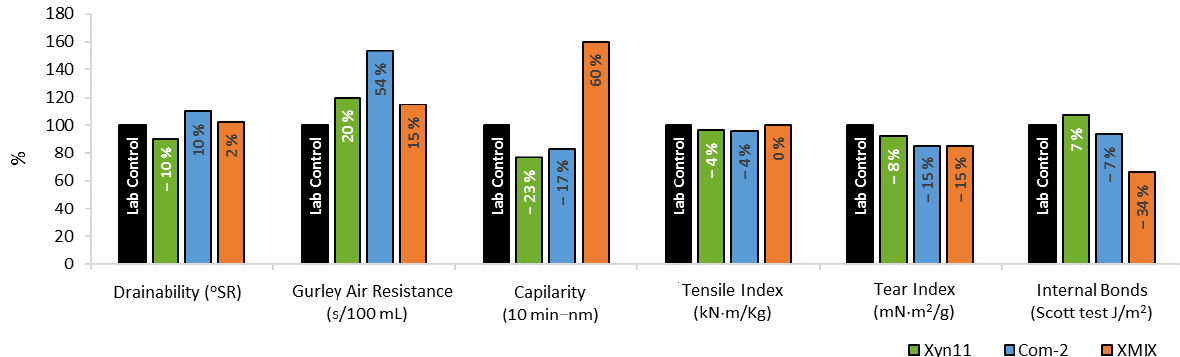
Figure 5. Papermaking properties obtained for pulps pretreated with different xylanases and bleached with 15% less ClO 2 compared to the control pulp (no xylanase addition) at laboratory scale.